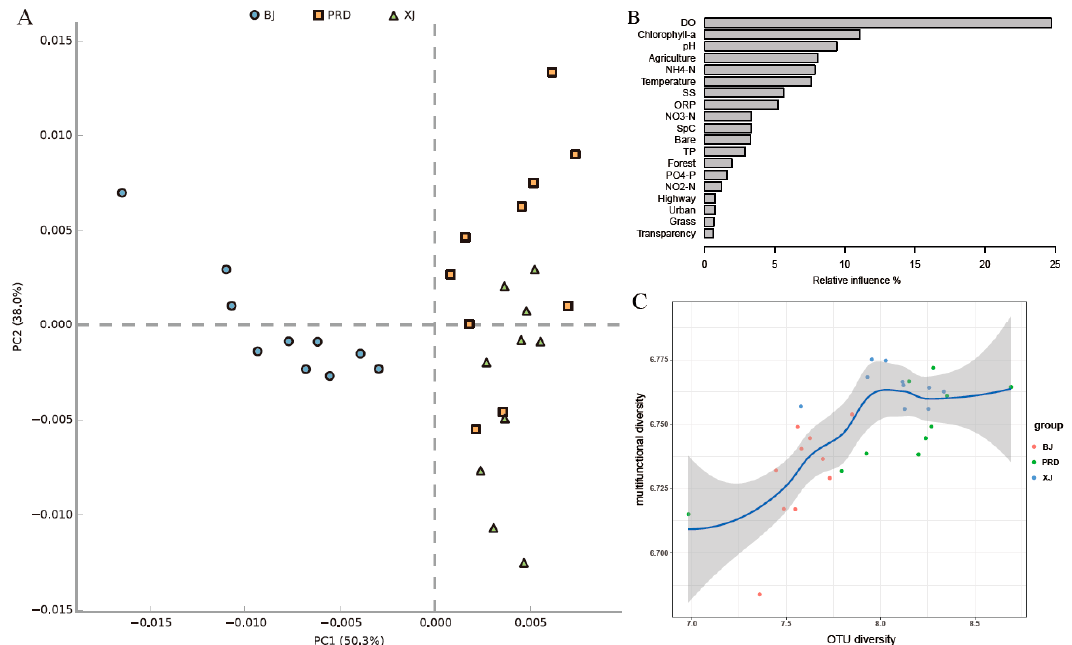
Figure 8. Predicted functional profiles and multifunctional diversities of bacterioplankton communities in the Pearl River. ( A ) Principal component analysis (PCA) of predicted bacterioplankton community function. ( B ) Relative influence (%) of environmental factors on multifunctional diversity via aggregated boosted tree models. ( C ) Relationship between operational taxonomic units (OTU) diversity and multifunctional diversity. Blue line indicates fit between OTU diversity (Shannon) and multifunctional diversity. Gray shadow under blue line represents 95% confidence intervals.